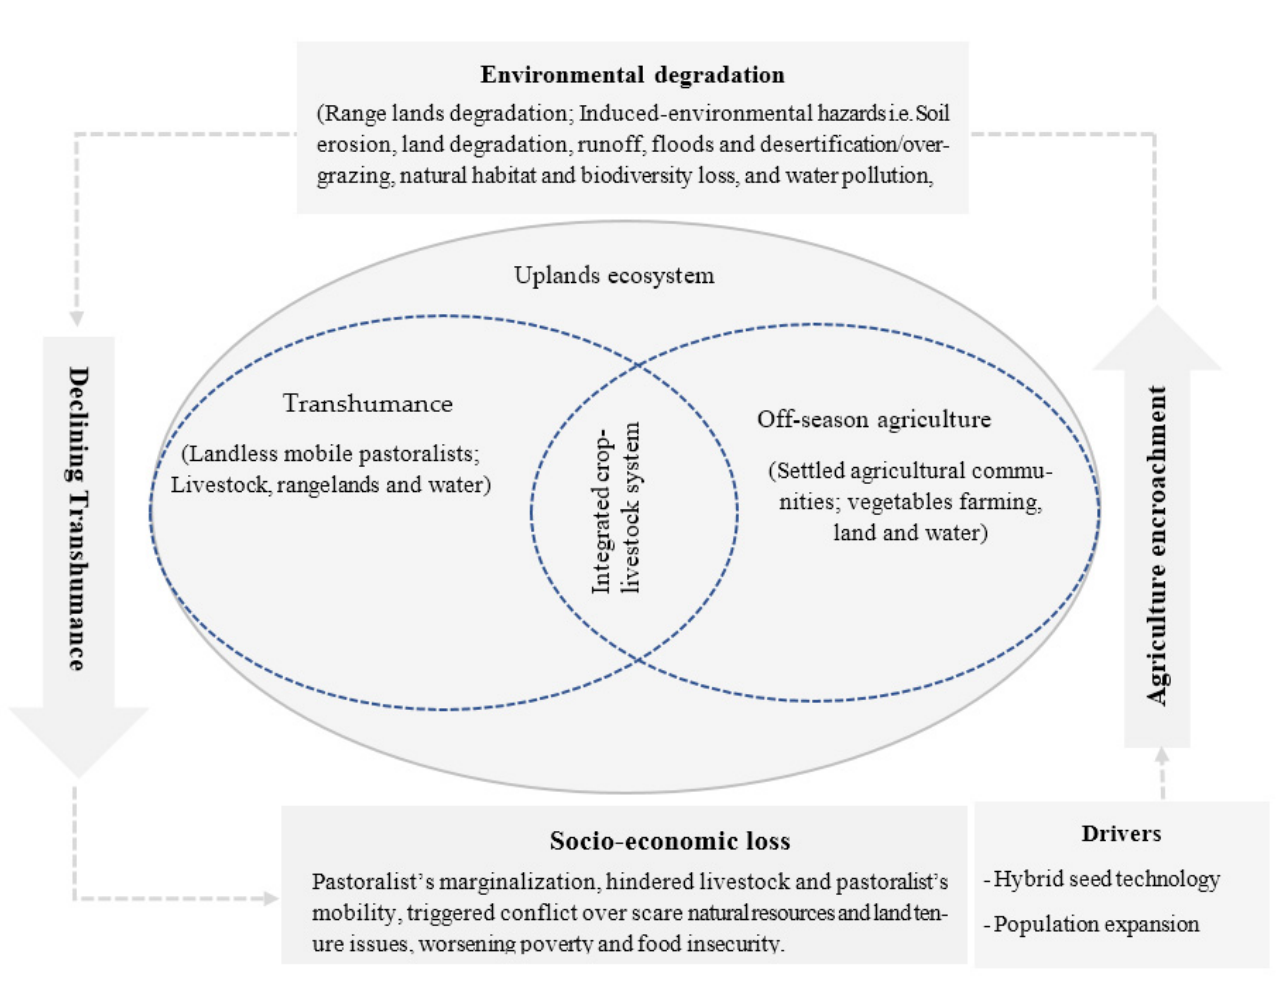
Figure 7. The framework of socio-ecological systems in the uplands of Naran.